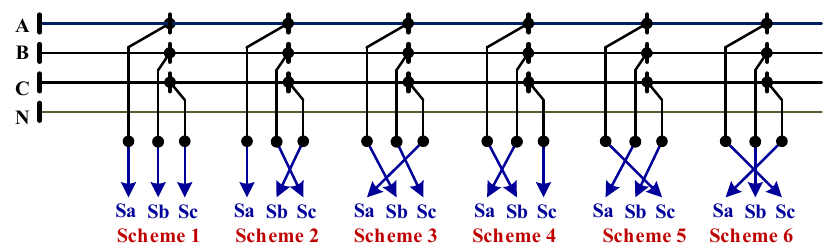
Figure 1. Six connection schemes for three-phase